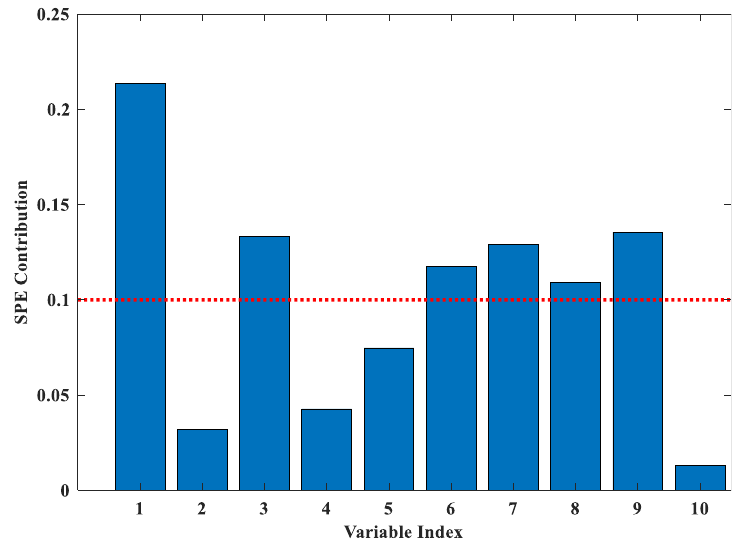
Figure 12. SPE contribution plot for fault diagnosis of F2 based on NMI-WMPCA.